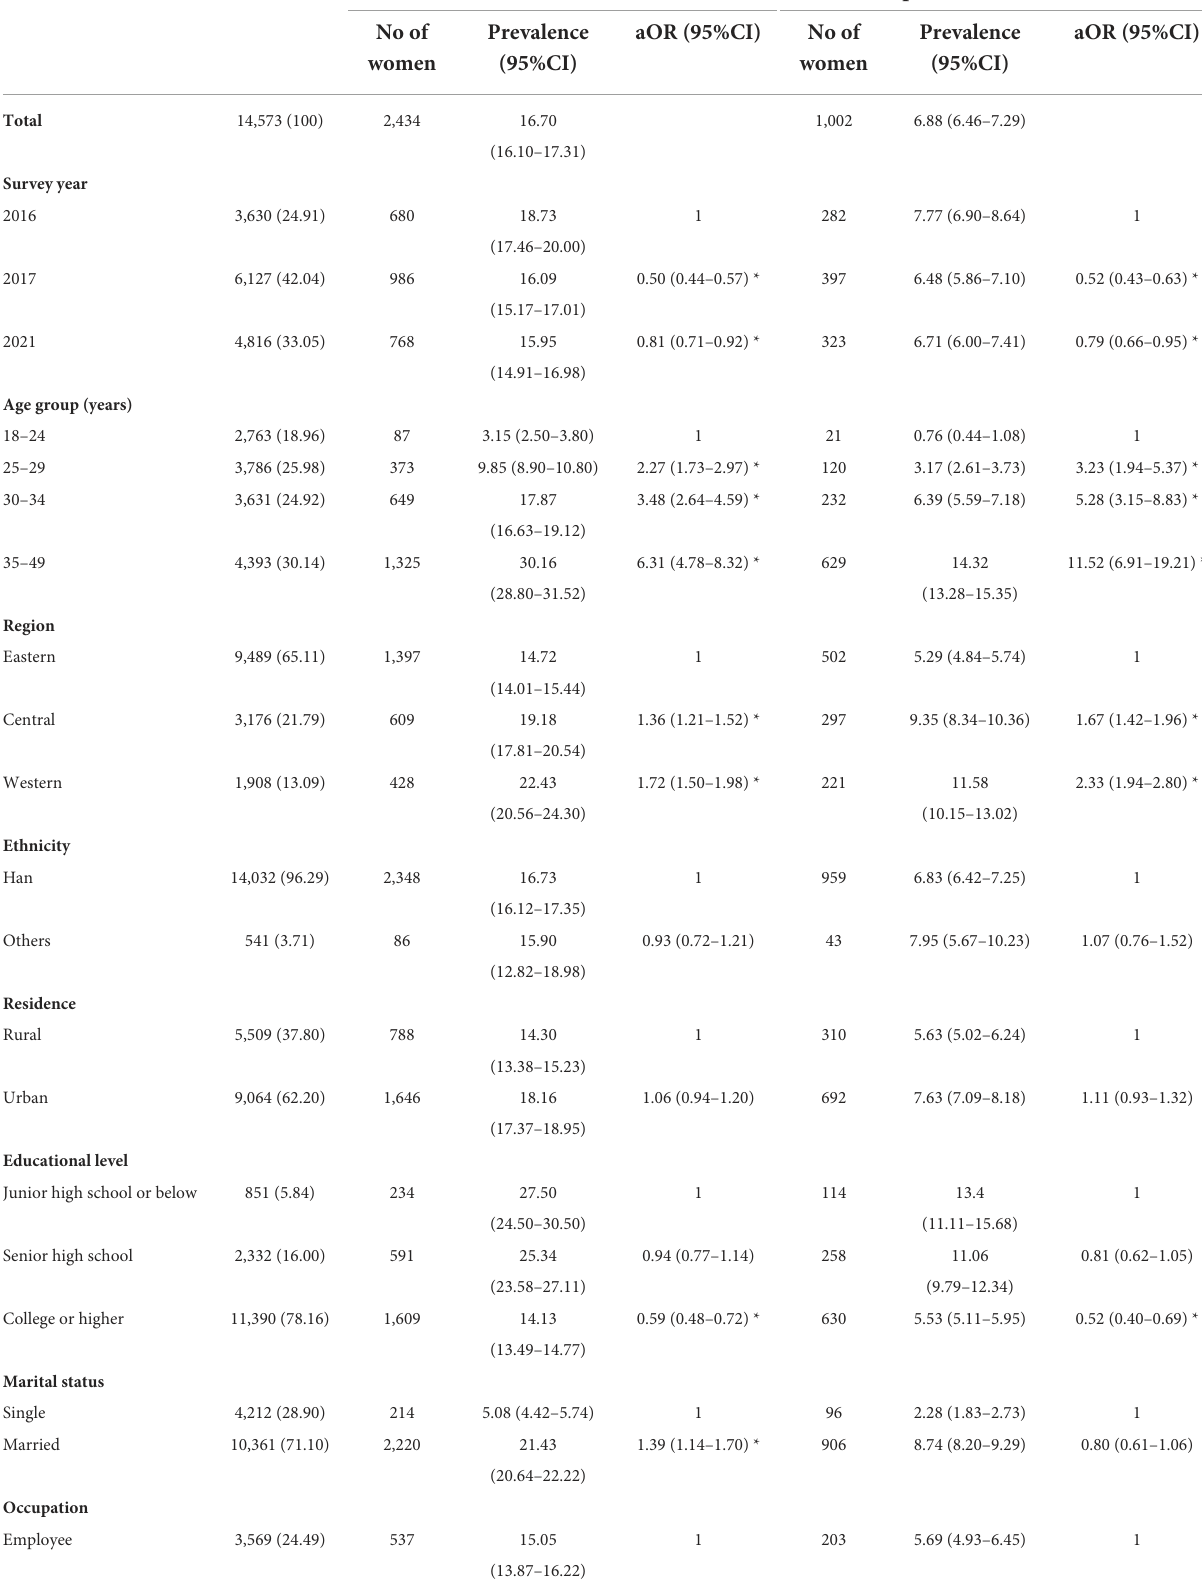
TABLE 1 The prevalence of induced abortion and repeated induced abortion among Chinese women aged 18–49 years.